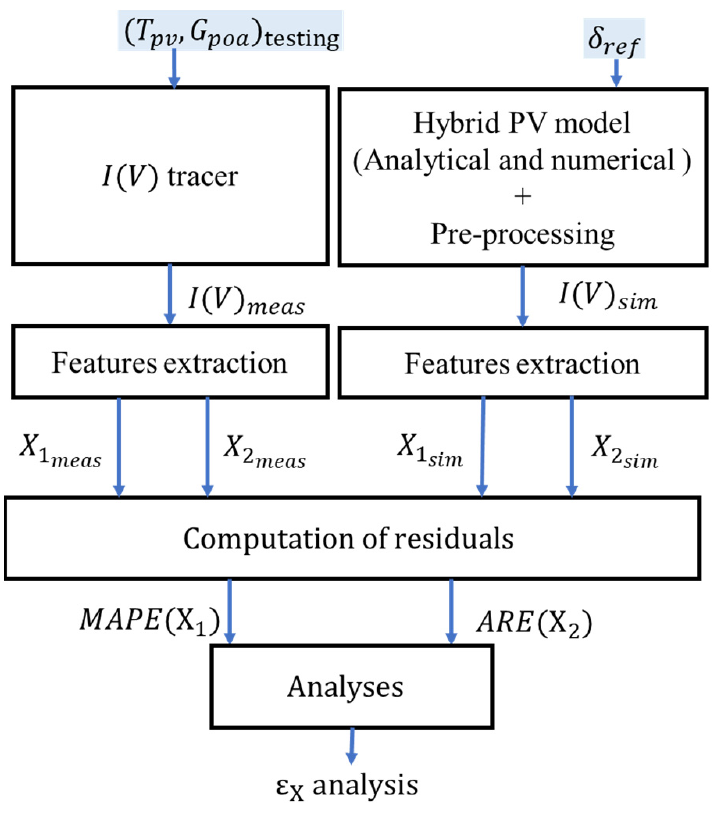
Figure 20. Flowchart to validate the hybrid PV model . Table 13. Data for the validation of the hybrid PV model